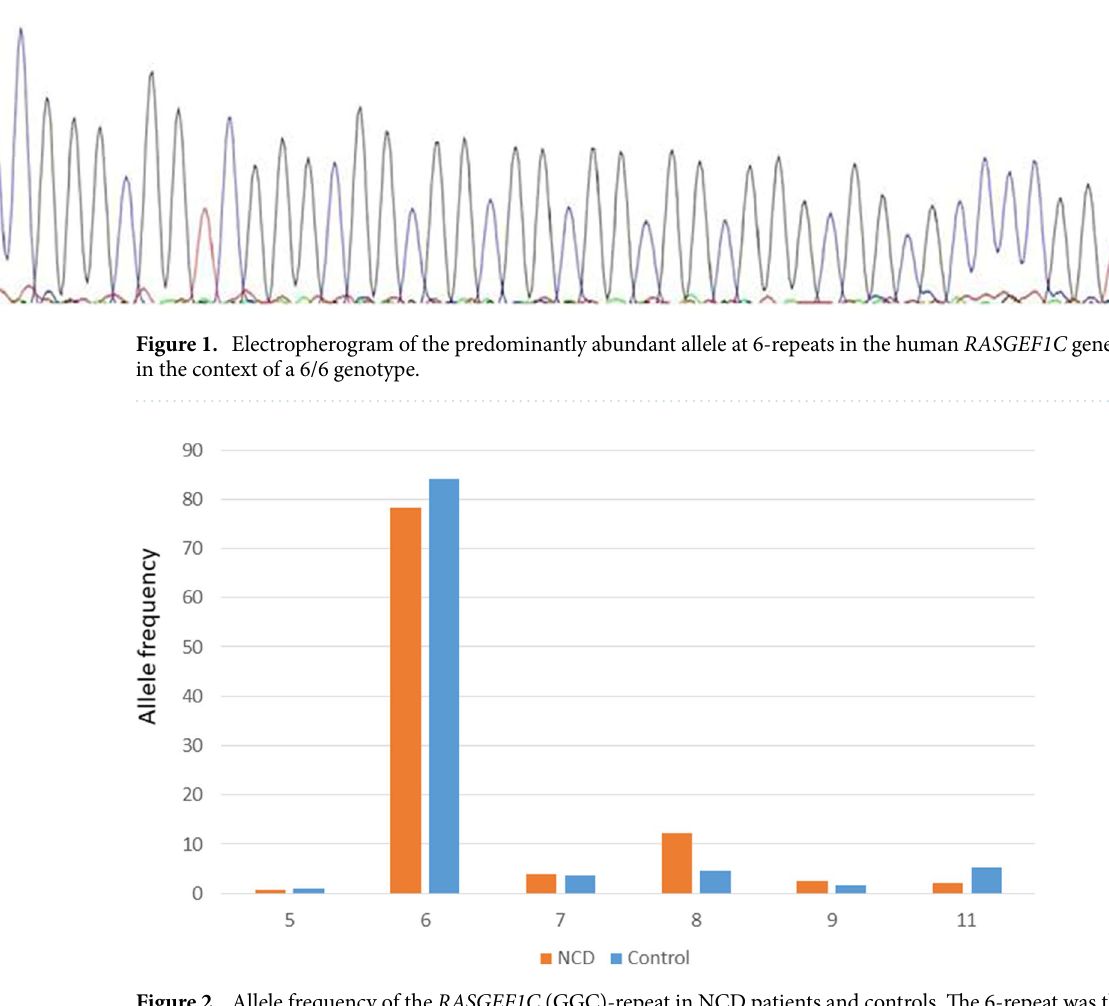
Figure 2. Allele frequency of the RASGEF1C (GGC)-repeat in NCD patients and controls. The 6-repeat was the predominant allele in both